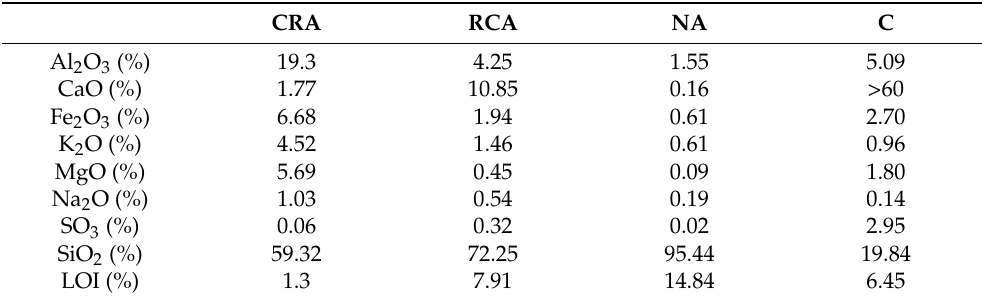
Table 2. XRF of used materials. C—cement, NA—natural aggregate, RCAs—recycled concrete aggregates, CRAs—recycled ceramic aggregates.